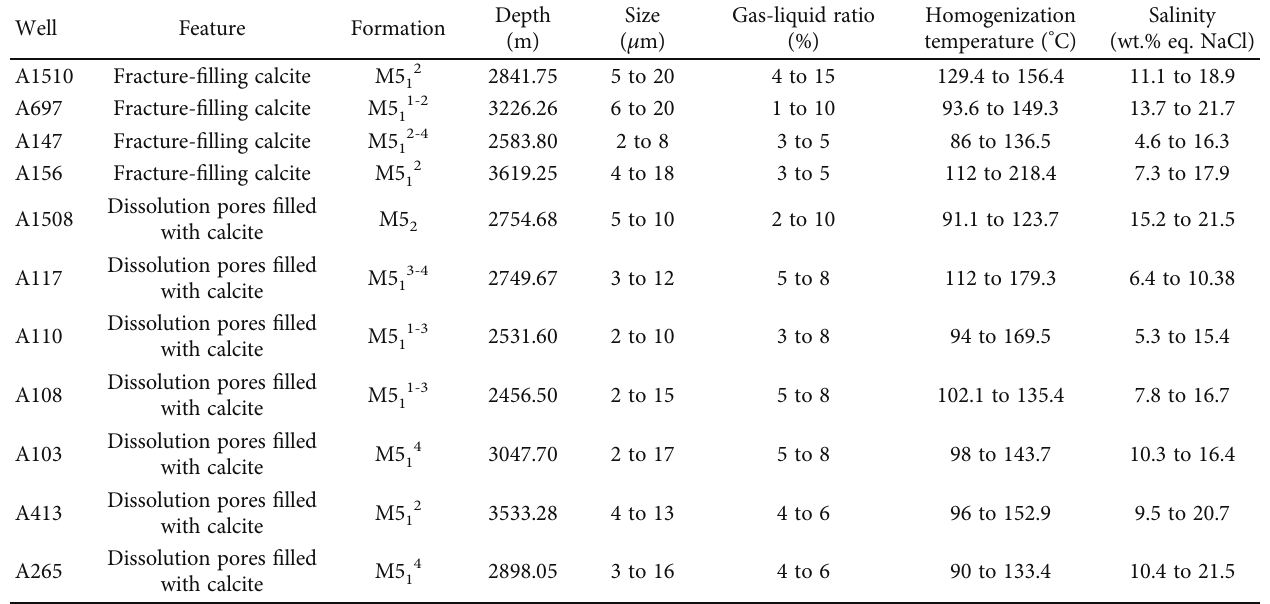
submember of Middle Ordovician Majiagou Formation in Yan ’ an area. 1-2